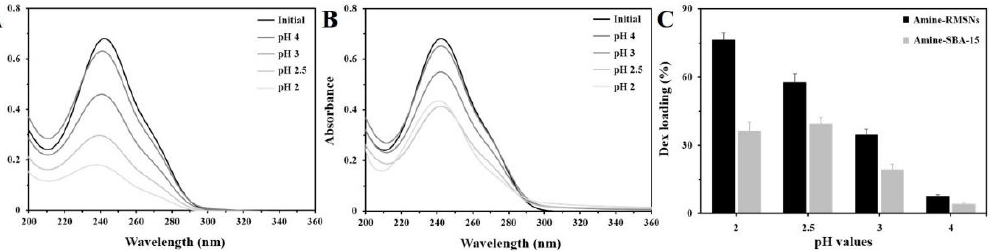
Figure 4. UV-Vis spectra for differences in the Dex loading efficiency according to pH treatment conditions on the surfaces of amine-RMSNs ( A ) and on amine-SBA-15 ( B ). Comparison of the Dex loading efficiency of amine-RMSNs with that of amine-SBA-15 ( C ) ( n = 3, mean ± standard